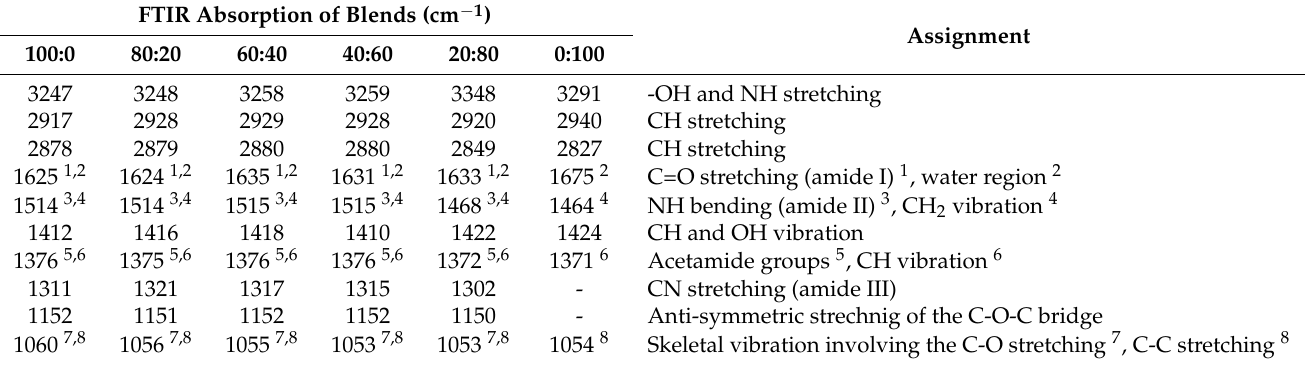
Anti-symmetric strechnig of the C-O-C bridge Skeletal vibration involving the C-O stretching 7 , C-C stretching